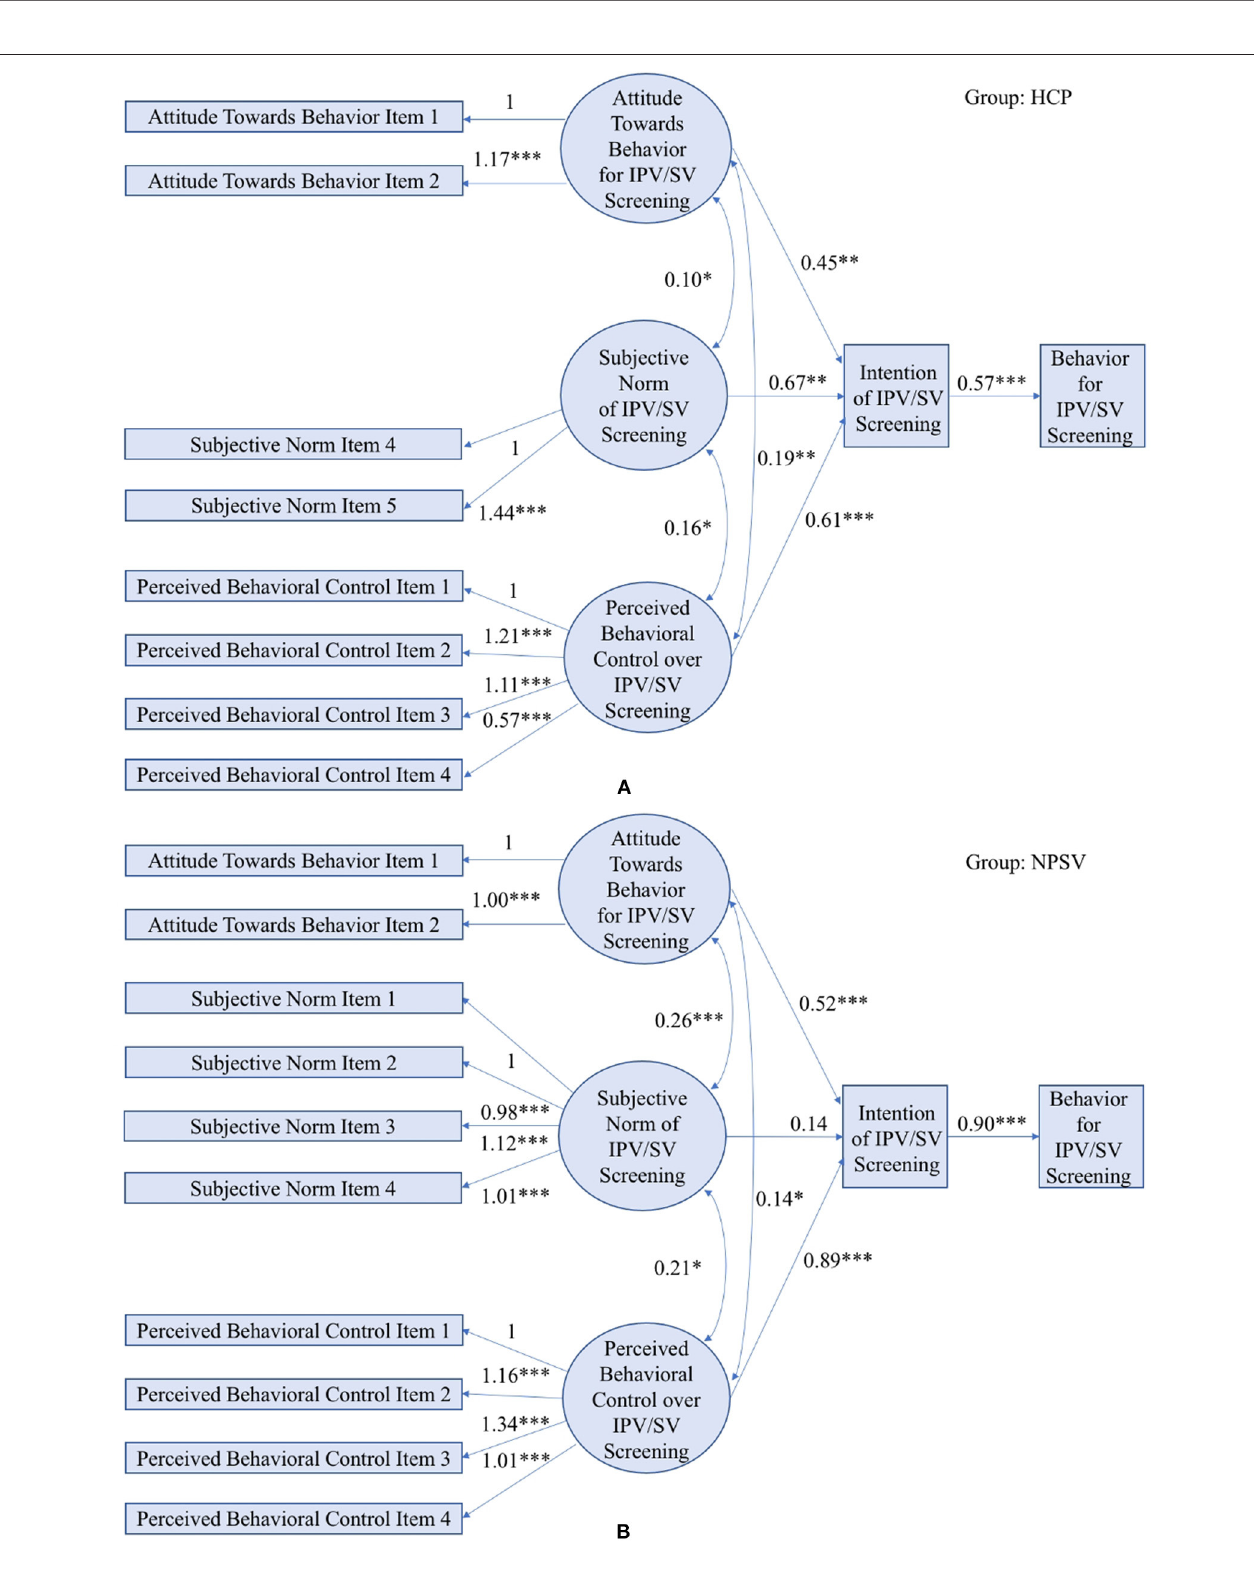
FIGURE 2 | An unconstrained multi-group SEM applied to TPB in the HCP study (A) and the NPVS study (B) . (Model fit indices: LRT p -value < 0.001, CFI = 0.96, TLI = 0.94, RMSEA = 0.074; *** indicates p -value < 0.001, ** indicates p -value < 0.01, * indicates p -value < 0.05).